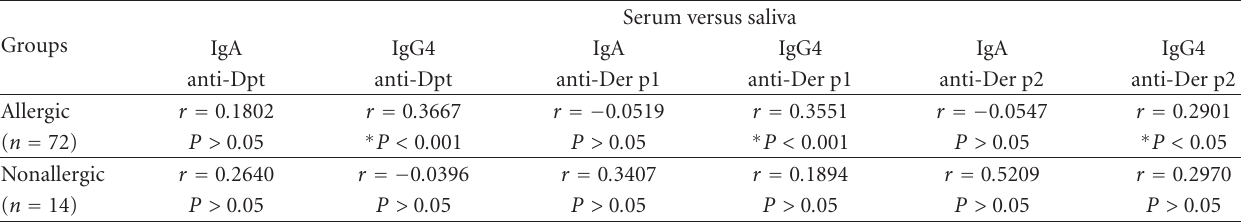
Table 2: Correlation between serum and salivary levels of IgA and IgG4 to Dermatophagoides pteronyssinus (Dpt) crude extract and its major allergens (Der p1 and Der p2) in allergic and nonallergic children.